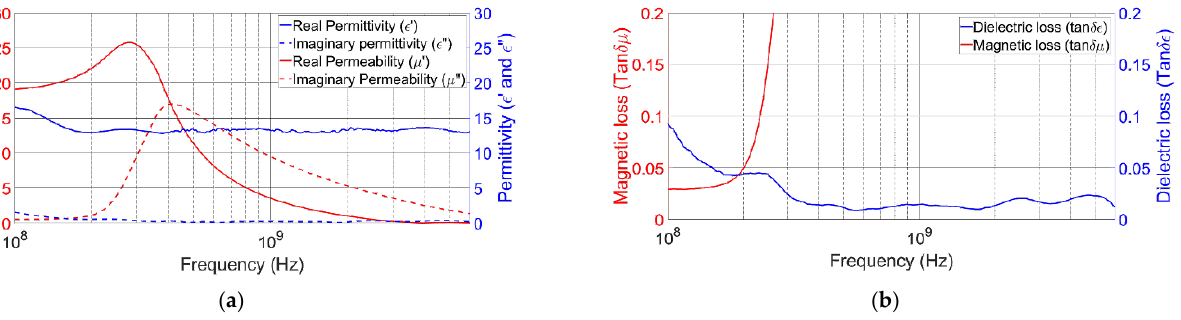
Figure 1. Manufactured MDM spectrum in the band 10 MHz – 6 GHz. ( a ) Typical measured relative permeability and permittivity. ( b ) Magnetic and dielectric loss tangents.